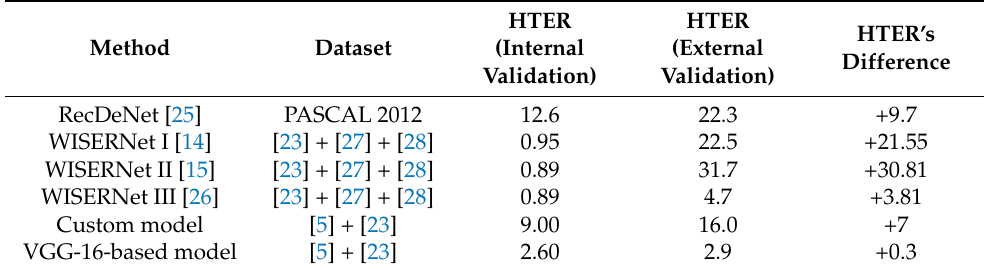
Table 4. Comparison of the proposed models with representative methods of the state-of-the-art approaches in terms of HTER (the lower the